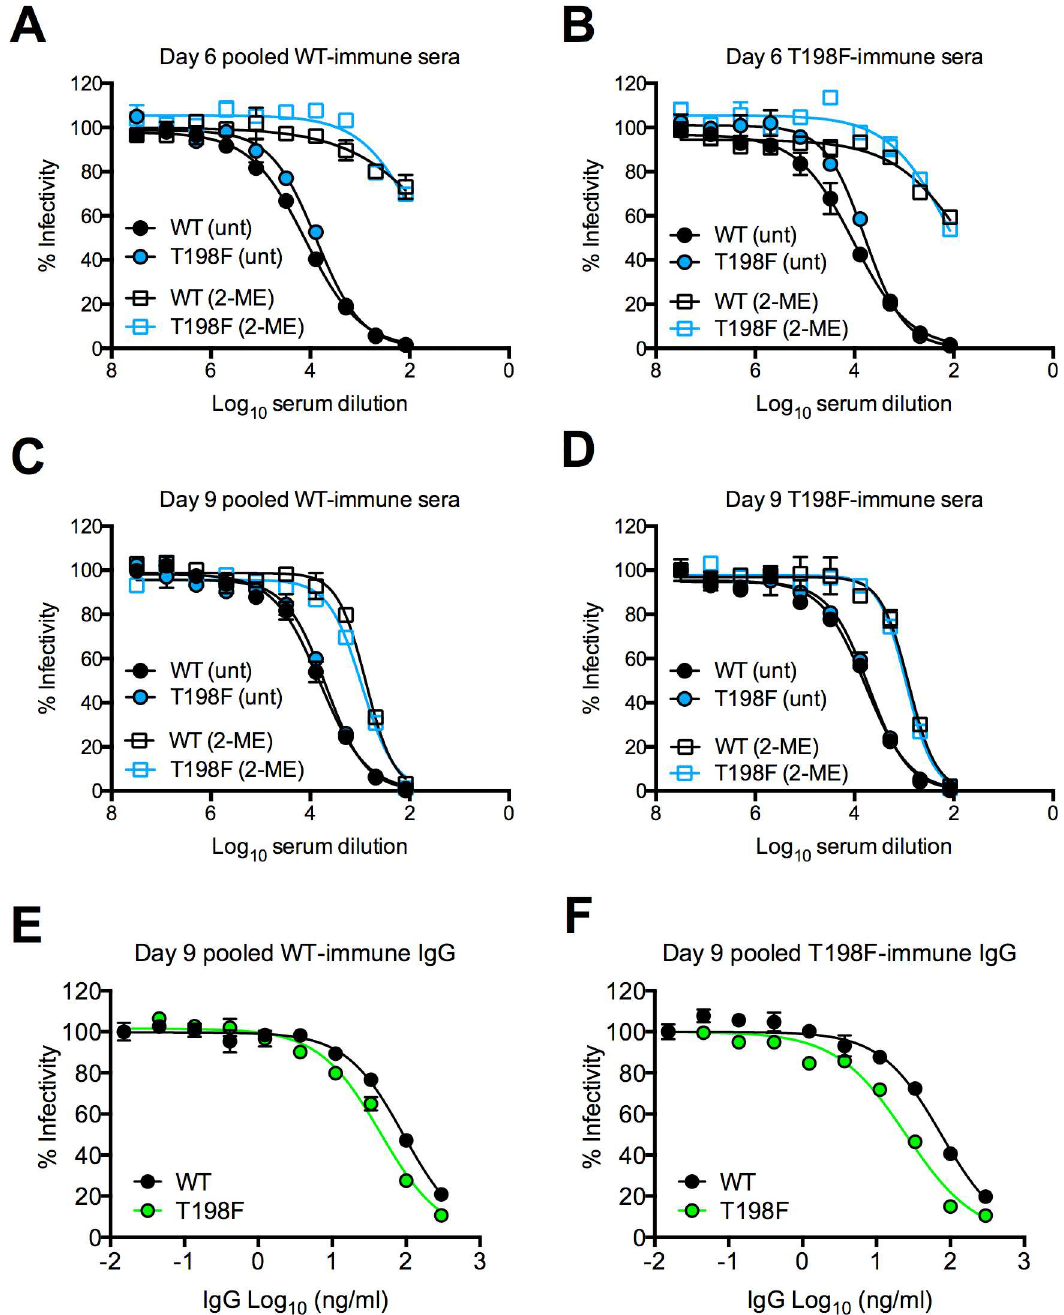
Fig 10. Neutralizing activity of WNV-immune sera. Sensitivity of WNV WT and T198F RVPs to neutralization by 2-mercaptoethanol(2-ME)-treated or untreated(unt) sera pooledfrom WT-immune (n = 5) (A and C) or T198F-immune (n = 5) (B and D) five-weekold WT C57BL/6Jmice. Sera were obtainedat 6 (A and B) and 9 (C and D) days post- infection. IgG purifiedfrom pooled (E) WT-immune (n = 5) or (F) T198F-immune (n = 5) sera obtainedfrom 9 days post- infectionwere tested for the ability to neutralize WNV WT and T198F RVPs. Error bars indicate the range of infectionfrom duplicatewells. Data in (A-F) are representative of four independent experiments performed using independentRVP